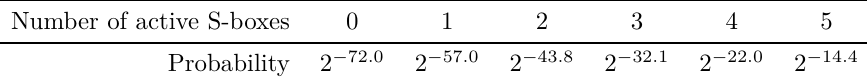
Table 6: Probability that a random data-round key difference leads to x active S-boxes for 3 R ′ . Number of active S-boxes